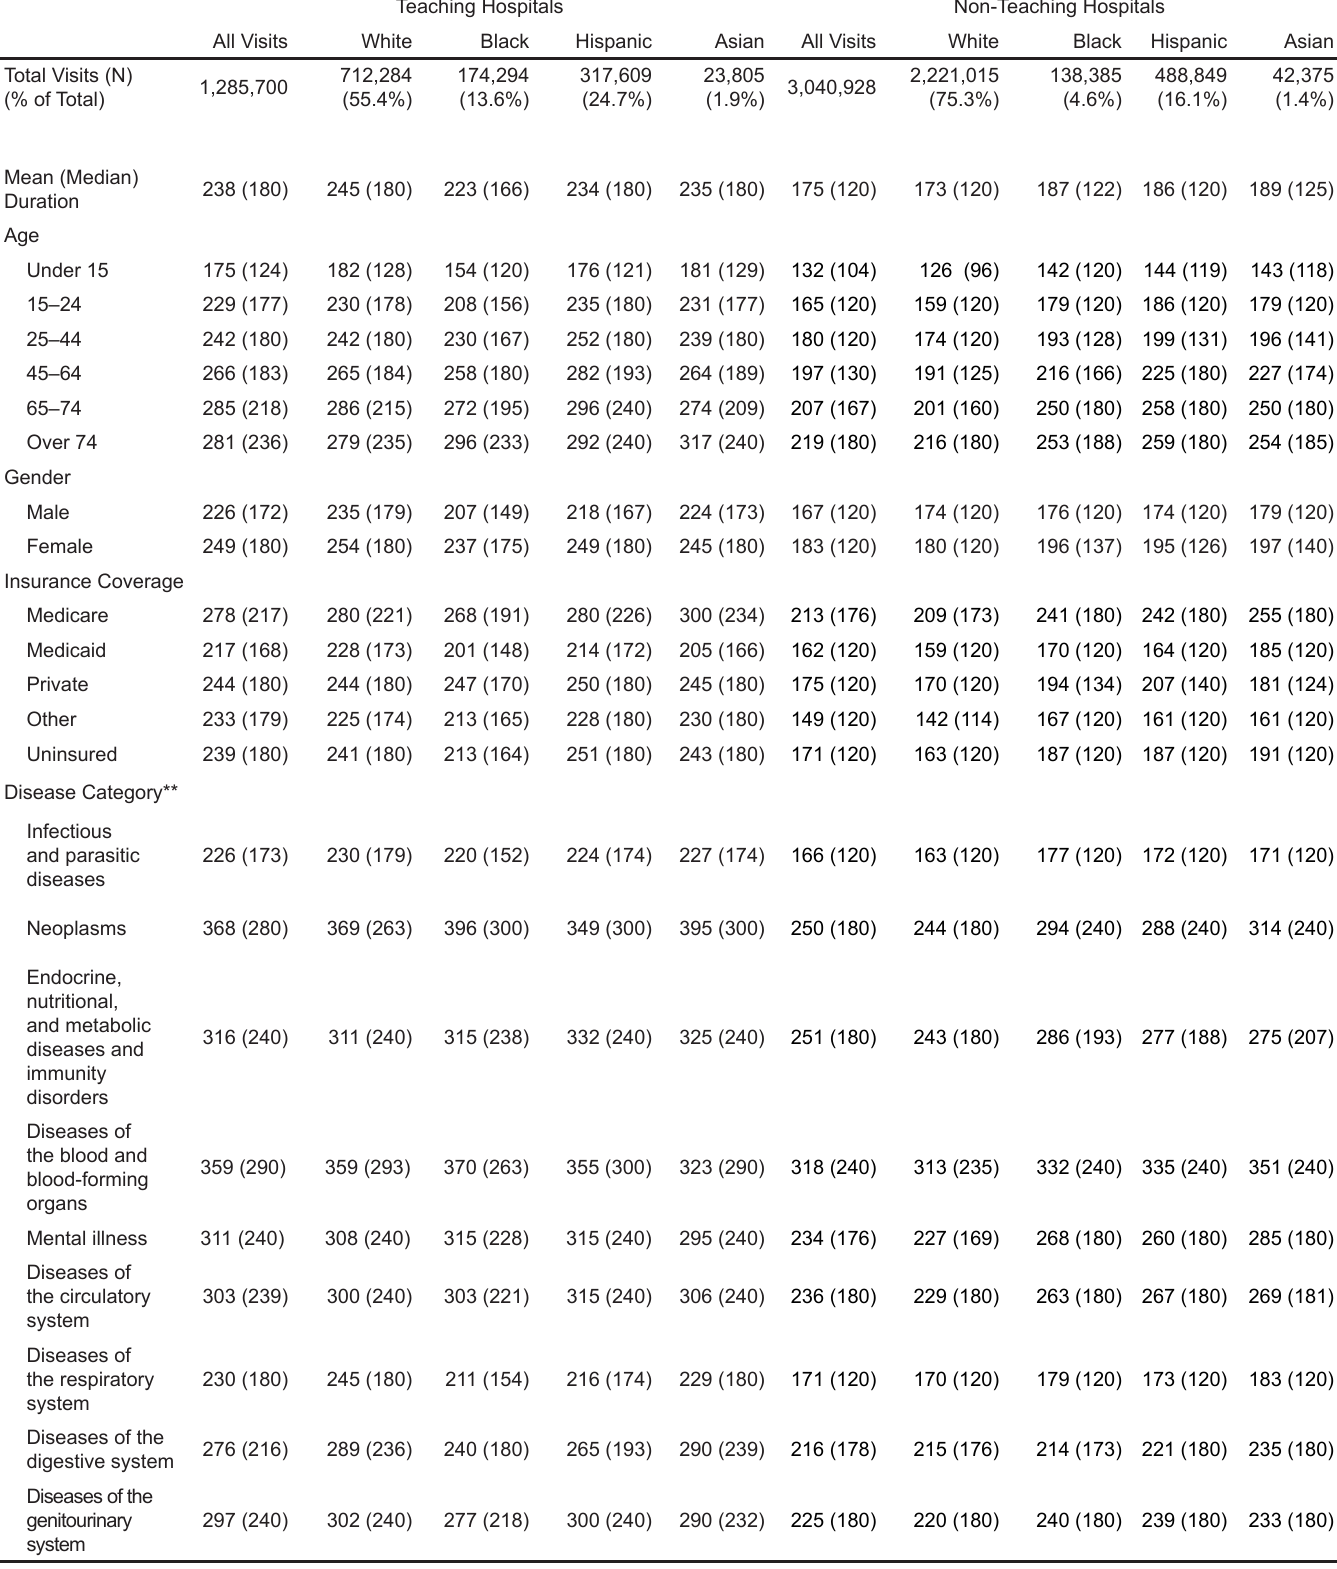
Table 1. Mean and median duration* of routine visits to hospital emergency departments by patient